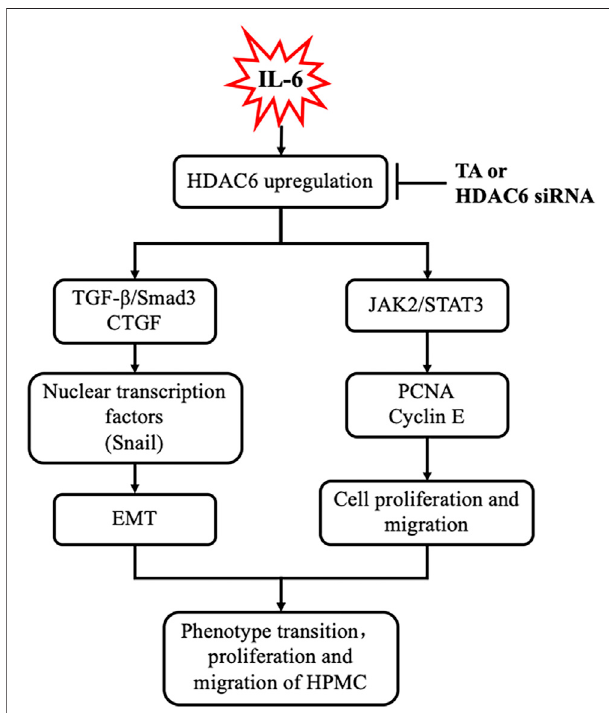
FIGURE 8 | Requirement of HDAC6 for IL-6 induced EMT, proliferation, and migration of peritoneal mesothelial cells resulted in an aggravation of peritoneal fi brosis. Exposure of IL-6 to the peritoneal mesothelial cells upregulates HDAC6, which leads to activation of TGF- β /Smad3 and JAK2/STAT3 signaling, subsequently inducing EMT (i.e., expression of CTGF and Snail), proliferation, and migration (i.e., production of PCNA and Cyclin E) response. All these responses are inhibited by TA or HDAC6